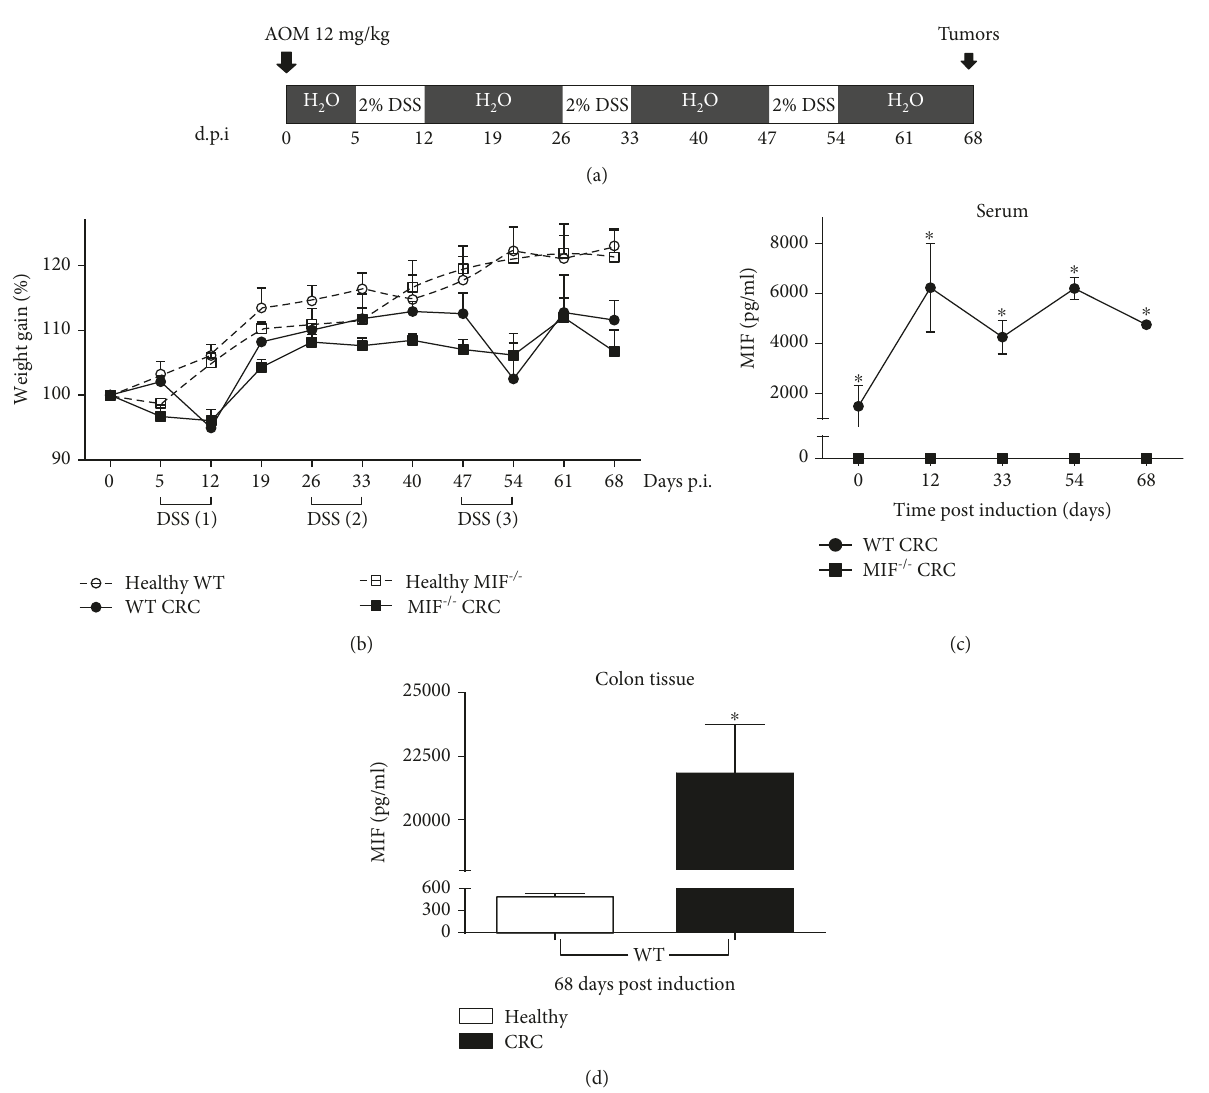
Figure 1: Chemical colitis-associated cancer increases serum MIF levels. (a) Both WT and MIF -/- female BALB/c mice were injected via intraperitoneal injection with AOM; then, 3 cycles of 2% DSS were administered in drinking water, each followed by 14 days of water free of DSS. (b) Weight gain was supervised during cancer development. MIF concentrations (c) in blood serum over time (after each DSS cycle at 12, 33, 54, and 68 days) and (d) in colonic tissue after 68 days were measured by ELISA. Data are representative of three independent experiments and are plotted as the means ( ± SEM), n = 3 mice per group; ∗ p < 0 05 , ∗∗ p < 0 01 , and ∗∗∗ p < 0 001 . MIF: macrophage migration inhibitory factor; CRC: colorectal cancer; AOM: azoxymethane; DSS: dextran sodium sulfate; d.p.i: days post